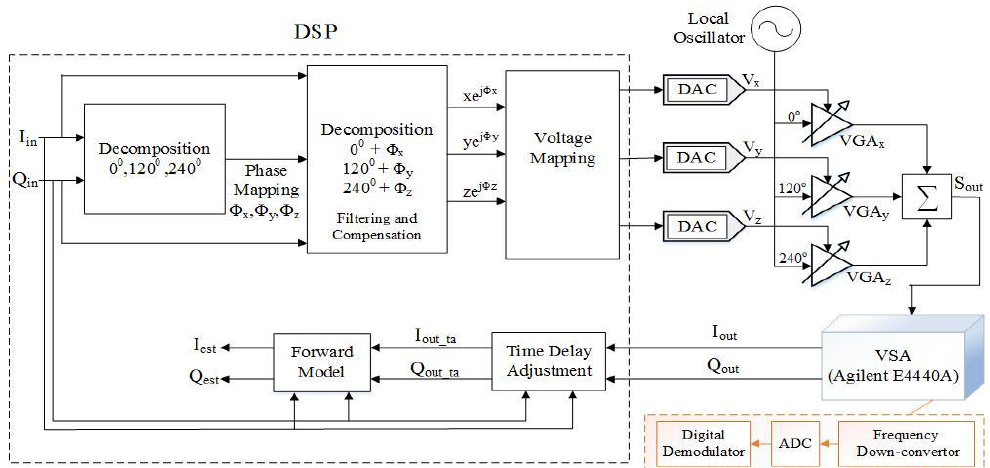
Figure 5. Block schematic of mixer-less three-way amplitude modulator-based transmitter, analog combining architecture with signal processing.